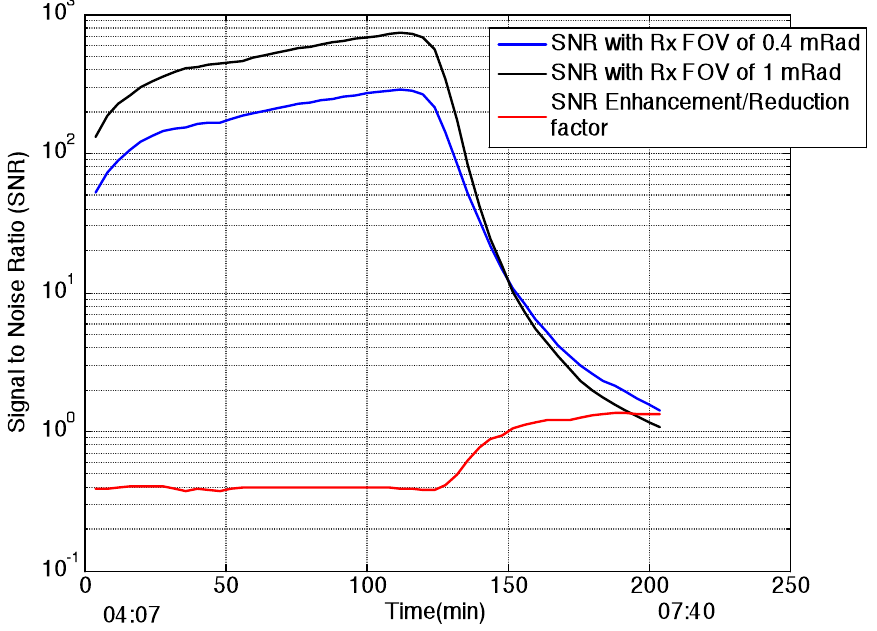
Figure 7. Lidar SNR values obtained at an altitude of 10 km on March 18, 2010, for a change in the FOV. The times of observations are given at the extreme ends of the plots, in local time.